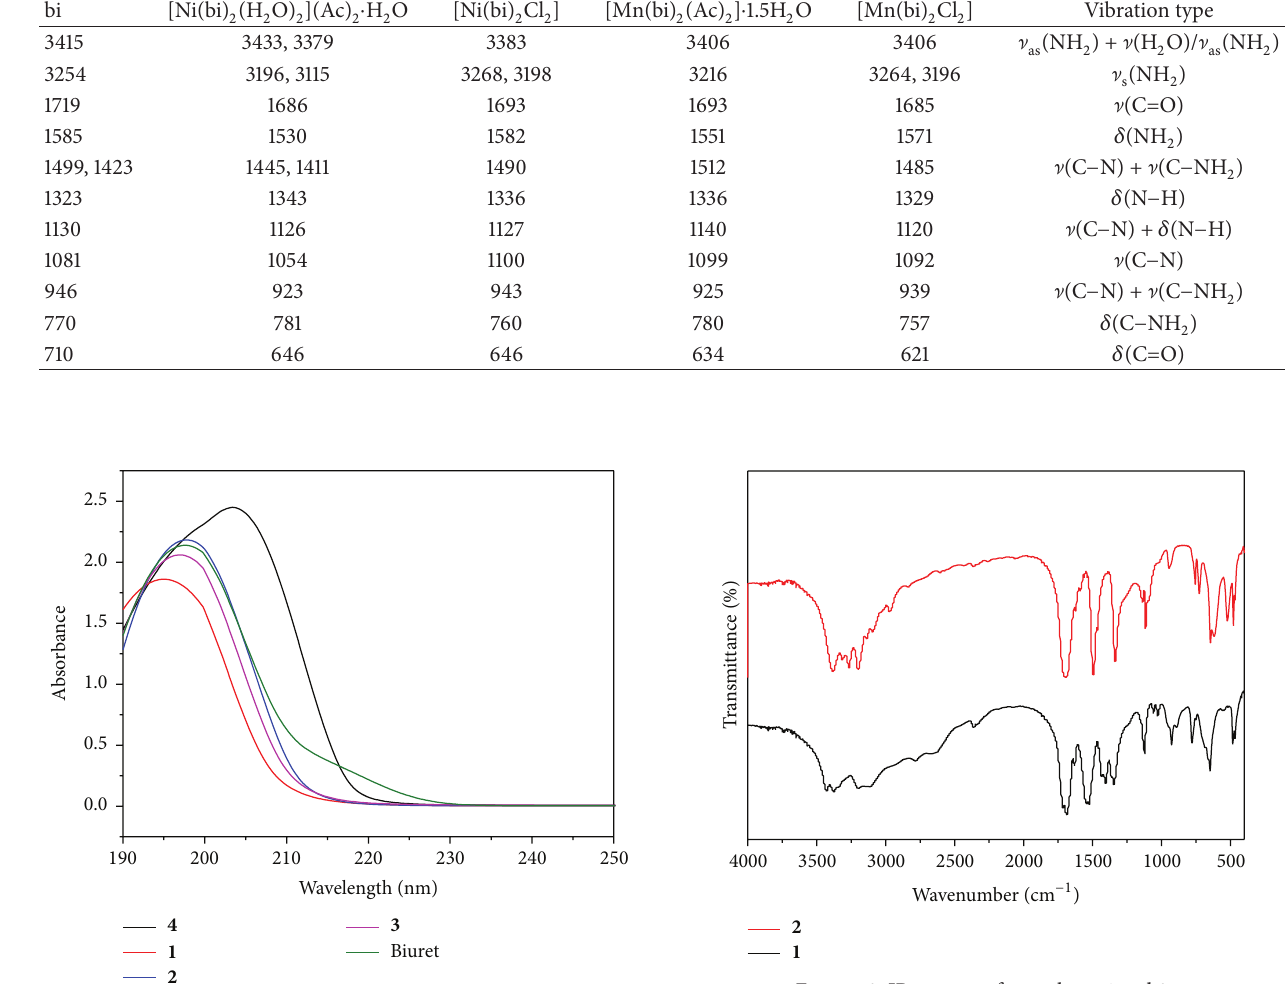
Figure 1: UV spectra of the complexes and biuret.